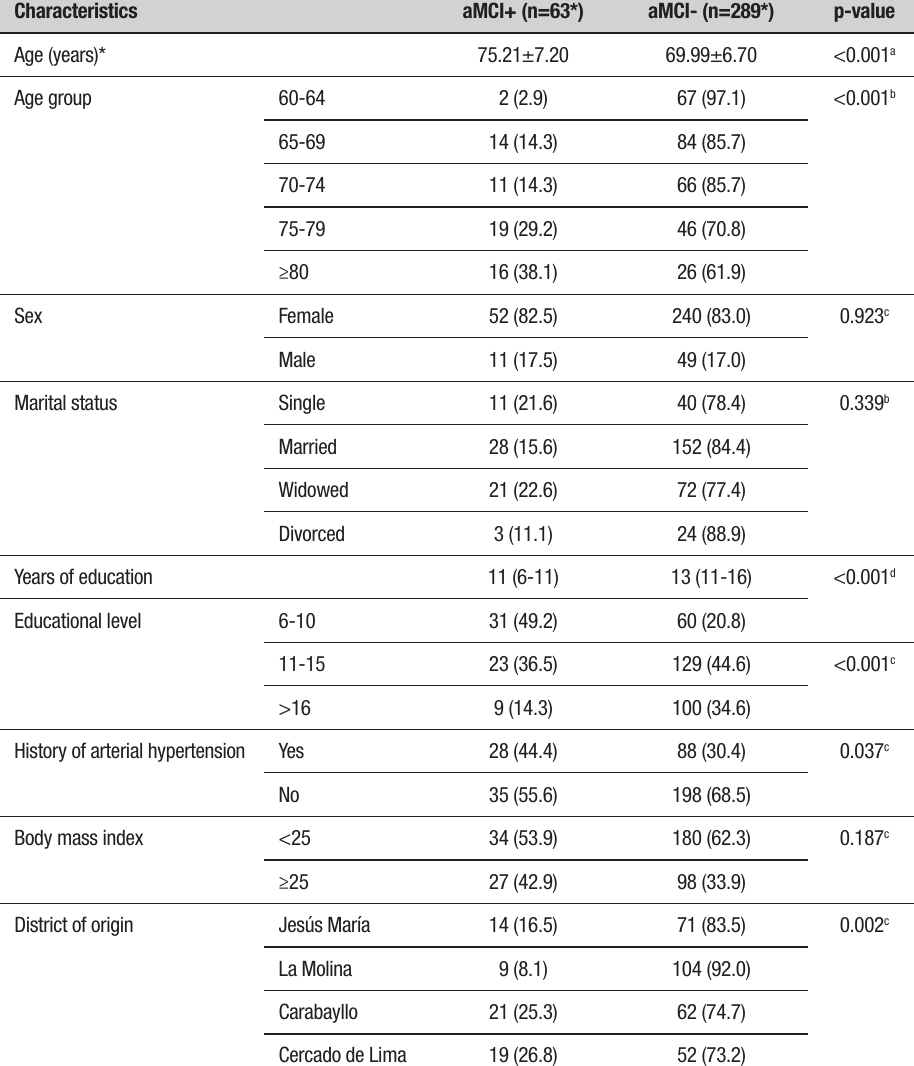
Table 2. Baseline sociodemographic characteristics of sample according to presence/absence of aMCI (n=352).